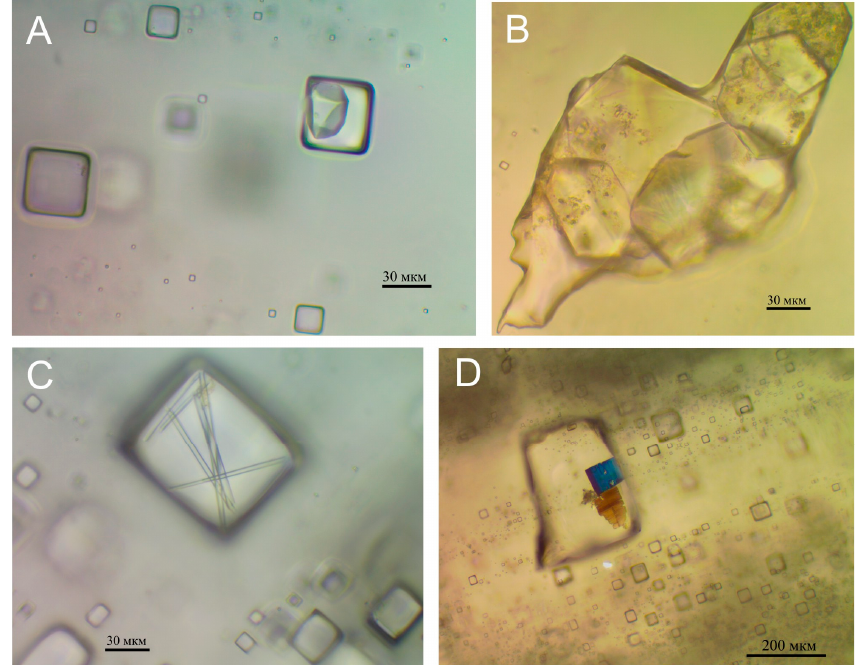
Figure 5. Calcium sulfate mineral crystals of fluid inclusions in halite. ( A ) Gypsum within primary inclusions, sample No. 11; ( B ) Gypsum in secondary inclusion, at the stage of diagenesis of rock salt, the dissolution of tiny gypsum crystals and the increase of individuals of this mineral took place in the newly formed large liquid inclusions, sample No. 4; ( C ) Bassanite, sample No. 11; ( D ) Anhydrite in secondary inclusion. For sample location, see Figure 2 and Tables 1–2. Glauberite (Na 2 Ca(SO 4 ) 2 ) is deposited either in sedimentary halite or in glauberite interlayers in rock salt of various samples. The glauberite crystals are colorless or yellow- ish beige (Figure 6) and have isometric, prismatic, and tabular habits. The color of the glauberite layers in rock salt range from greenish to grey and yellowish to white, depend- ing on the amount of terrigenous material they contain. According to XRD analysis, it was established that anhydrite is noted in the compo- sition of glauberite monocrystals (sample No. 6 and No. 9 in the amount of 3% and 1%, respectively) and in the water-insoluble residue of sedimentary halite of sample No. 8 only glauberite is confirmed. In sample No. 3.97% glauberite, 3% thenardite, and less than 1% anhydrite is determined.